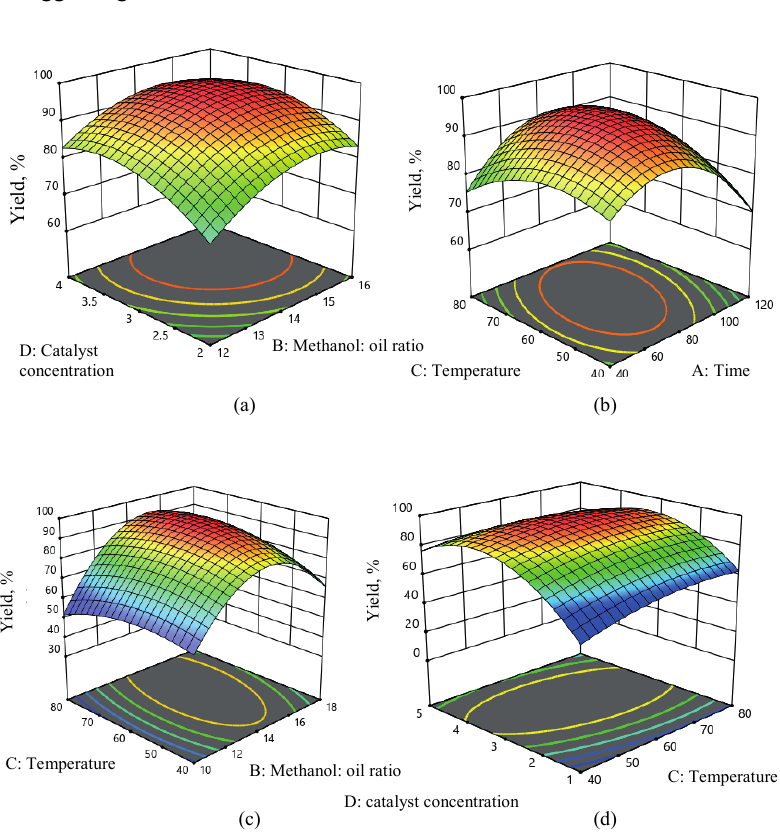
Fig. 3. Combined effects of the independent variables on the biodiesel